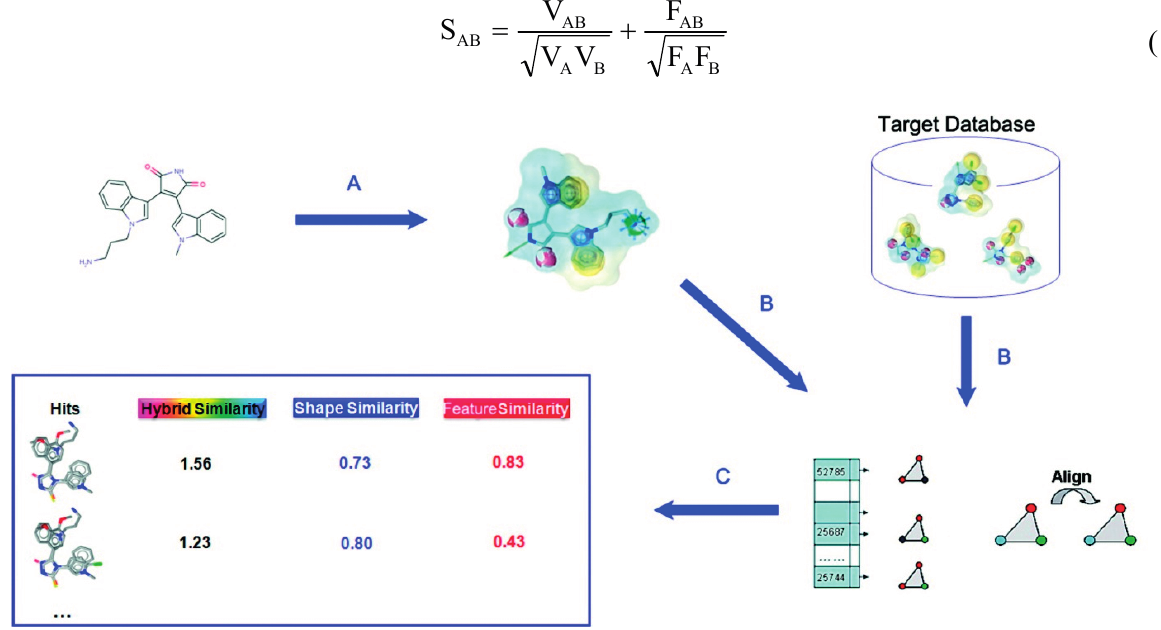
Figure 1. Schematic illustration of SHAFTS procedure. ( A ) Generate pharmacophore feature points of selected active molecule; ( B ) Search a database by superimposing feature triplet; ( C ) Rank compounds by the similarity score. Reprinted with permission from [23]. Copyright (2015) American Chemical